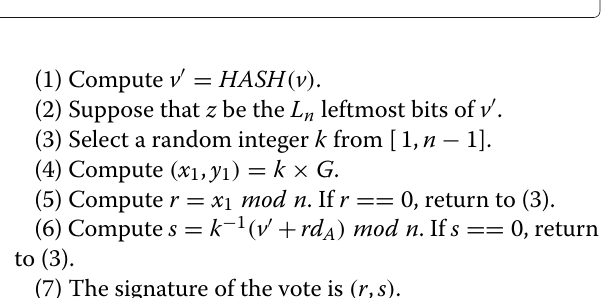
Fig. 2 The blockchain for